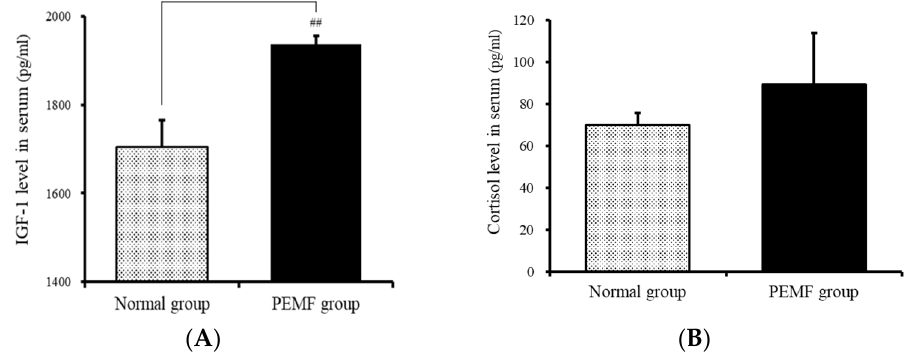
Figure 7. Effect of PEMF treatment on circulating ( A ) IGF-1 and ( B ) cortisol levels in the serum. Results are expressed as means ± SEM (n = 8). ## p < 0.01 compared with the normal group.